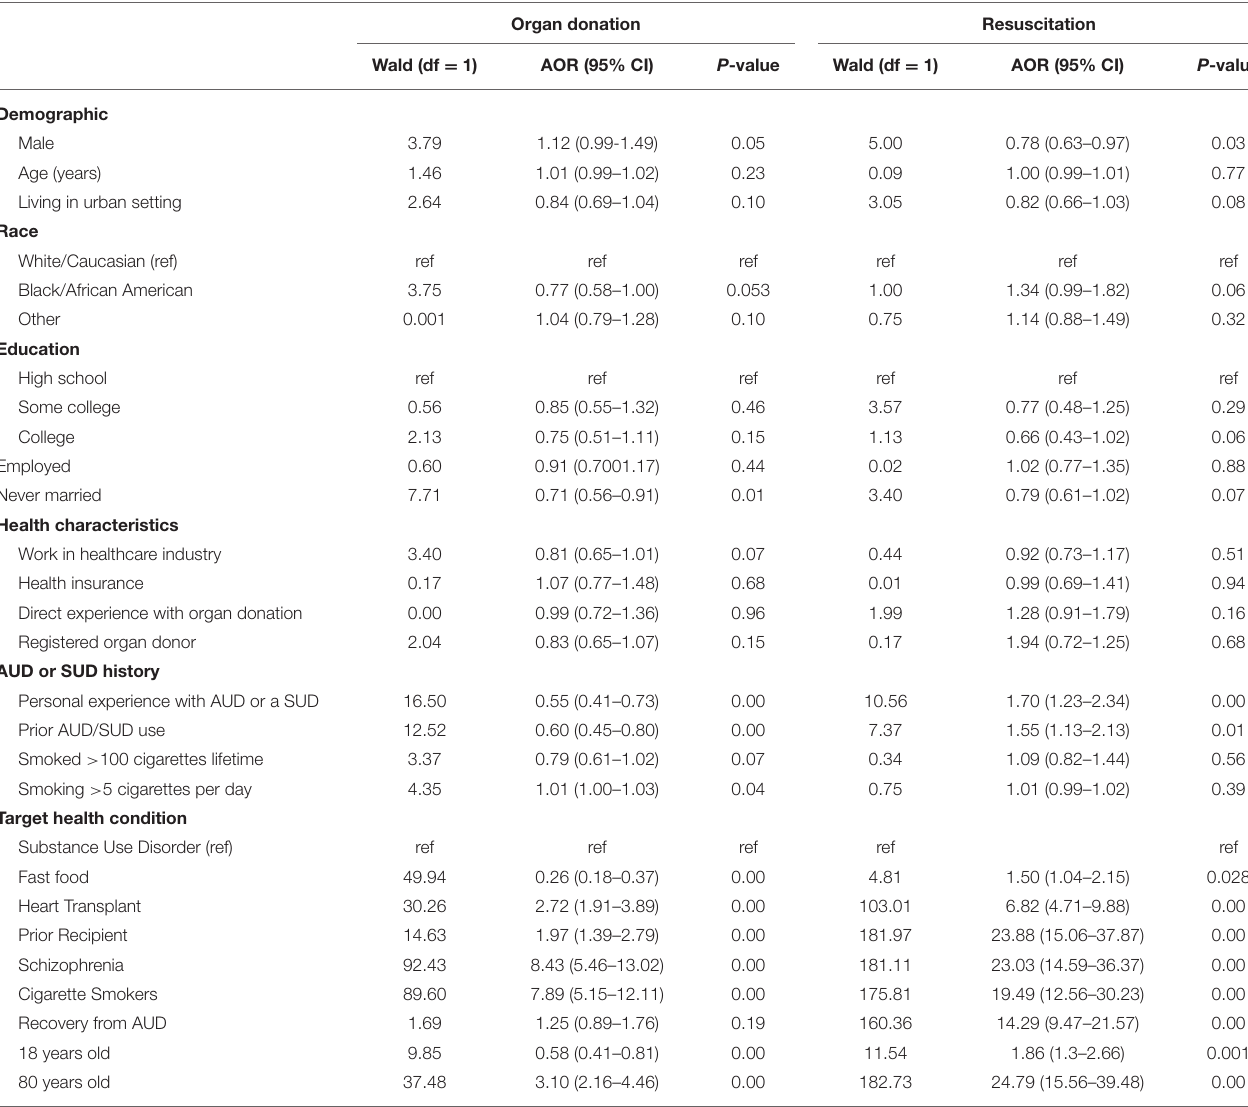
TABLE 3 | Multivariate evaluation of stigma as a function of target health